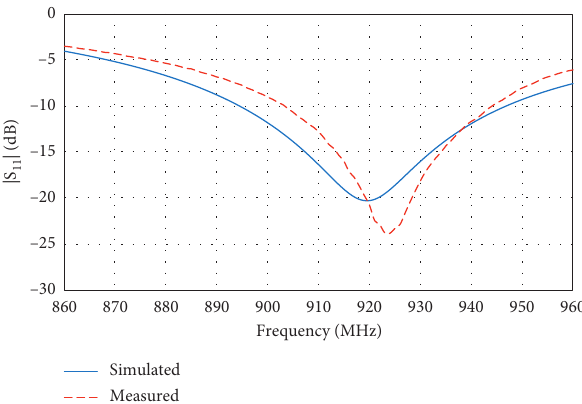
Figure 17: The simulated and measured AR of the UHF-RFID tag